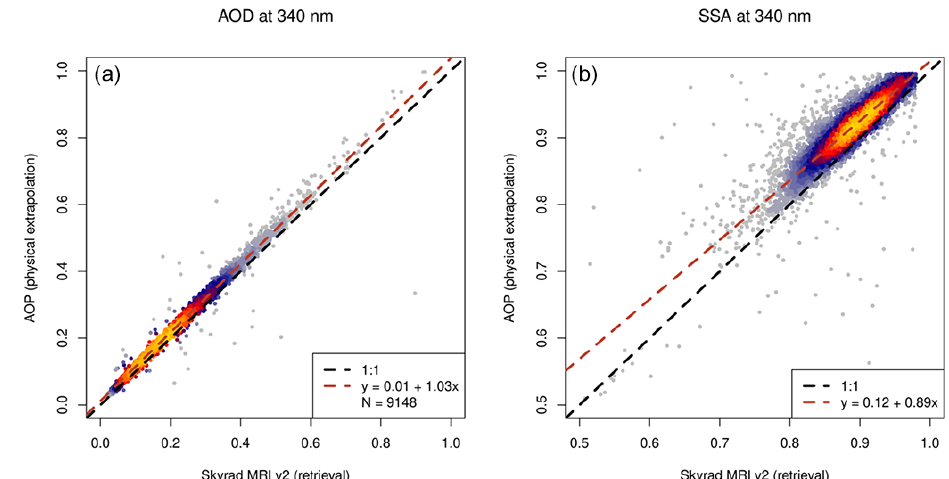
Figure 1. Comparison of the AOD (a) and SSA (b) at the wavelength of 340nm retrieved from Skyrad MRIv2 using measurements at all wavelengths as input ( x axis) and the physically based extrapolation from the visible IR ( > 400nm) to 340nm based on the AOP program ( y axis). Colors represent the density of the points based on a two-dimensional kernel density estimation (Venables and Ripley, 2013). Data refer to the period 2017–2020, i.e., a period when measurements in the 340nm channel were